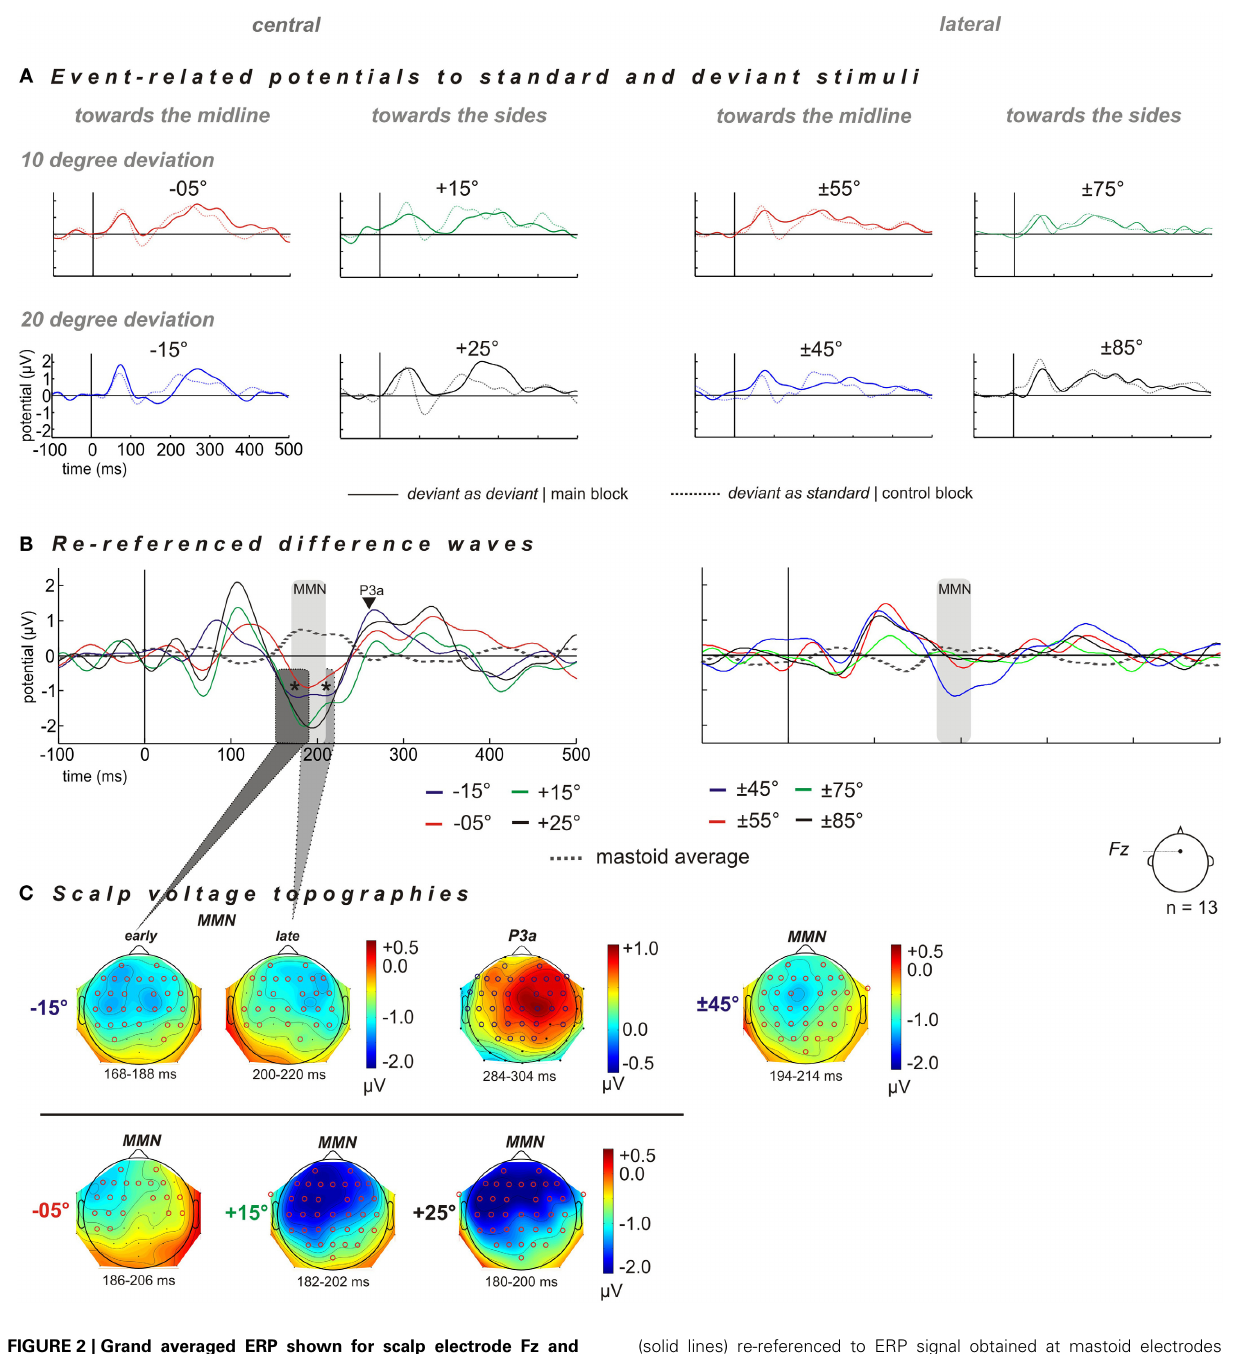
FIGURE 2 | Grand averaged ERP shown for scalp electrode Fz and distribution of deviant-related activity obtained for central (left column) and lateral (right column) reference positions. The spatial deviations relative to the standard positions are color-coded: blue − 20 ◦ and red − 10 ◦ for spatial displacements toward the midline , and green + 10 ◦ and black + 20 ◦ for spatial displacements toward the sides. Central stimulation: deviant positions at − 15 ◦ (blue), − 05 ◦ (red), + 15 ◦ (green), and + 25 ◦ (black). Lateral stimulation: deviant positions at ± 45 ◦ (blue), ± 55 ◦ (red), ± 75 ◦ (green), and ± 85 ◦ (black). (A) Grand averaged ERP to “deviant as deviant” (solid line) and “deviant as standard” (dashed line). (B) “Deviant as deviant”–“deviant as standard” ERP difference waves